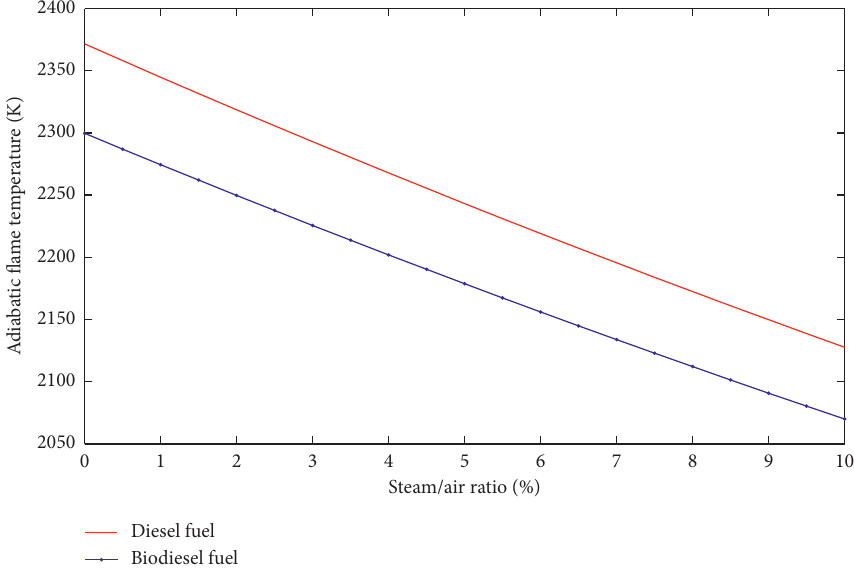
Figure 10: Adiabatic flame temperature comparison of biodiesel and diesel fuels at ϕ �